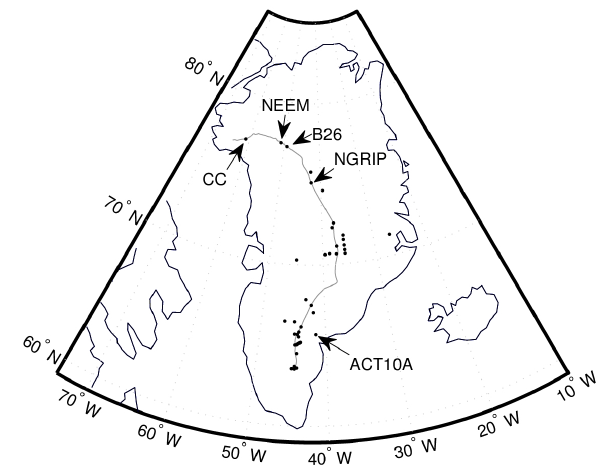
Fig. 1. The 52 ice core locations listed in Table 1. The five locations from which we have data for the most recent decade are indicated with labeled